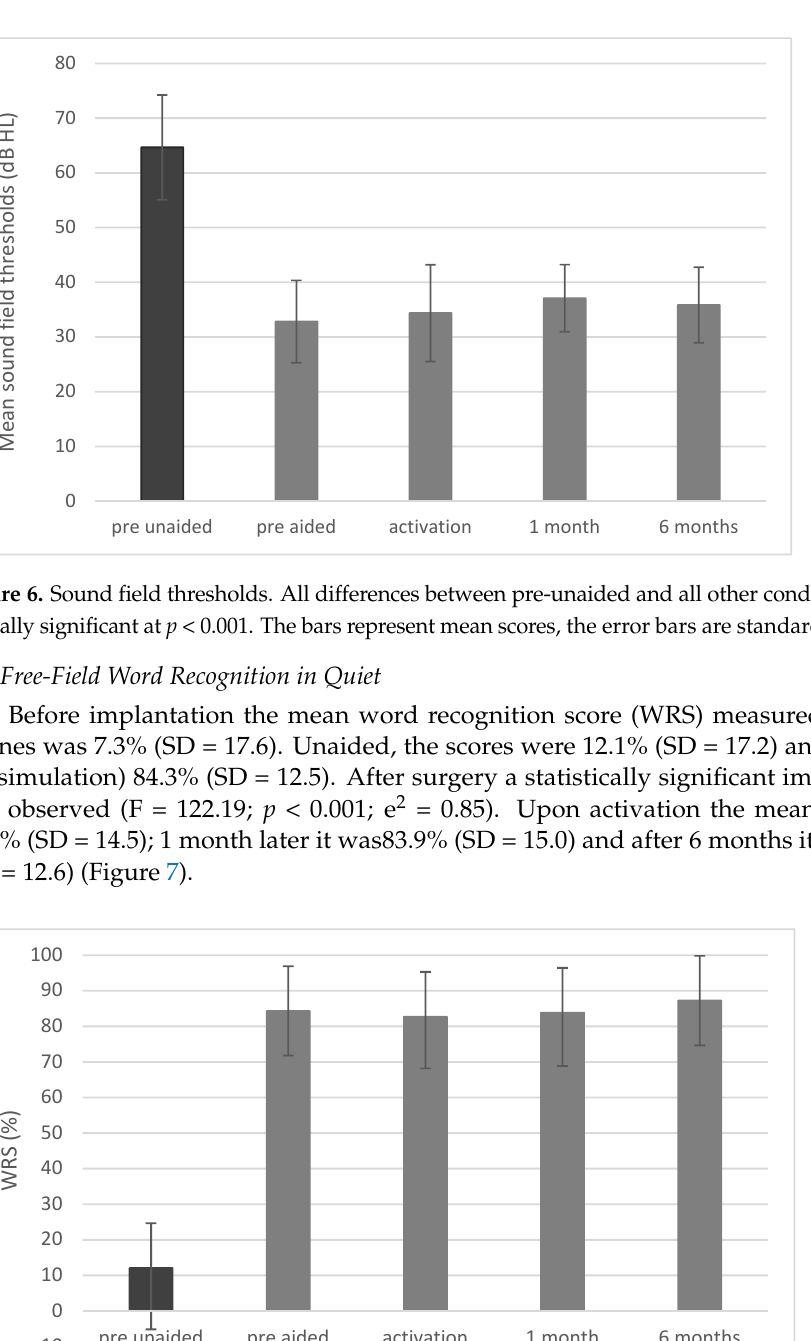
Figure 5. Functional gain; unaided and 6 months aided.